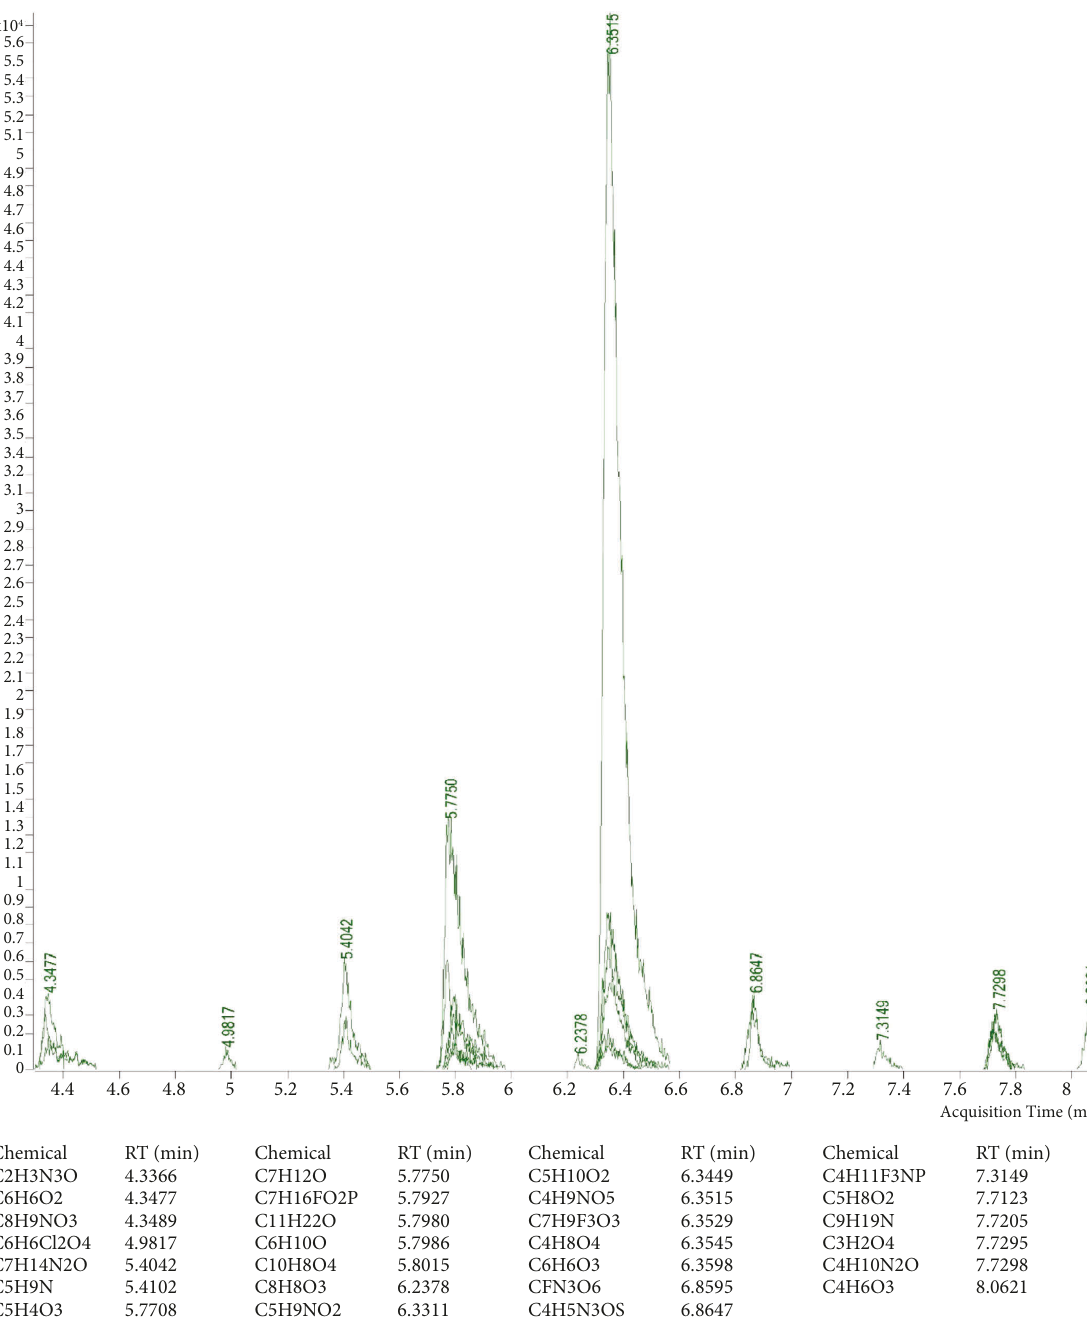
Figure 3: GC-MS chemical characterization of a polar extract of date pits. RT: retention